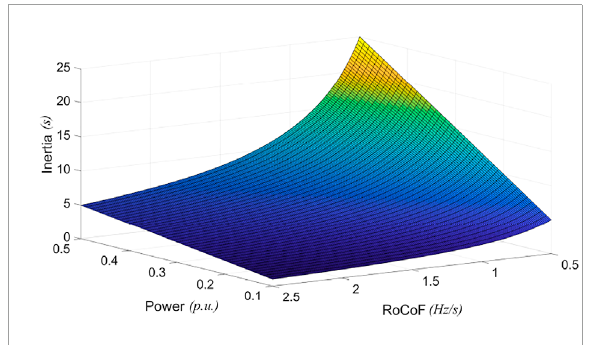
FIGURE 7 Relationships of inertia and power in different RoCoF limitations.